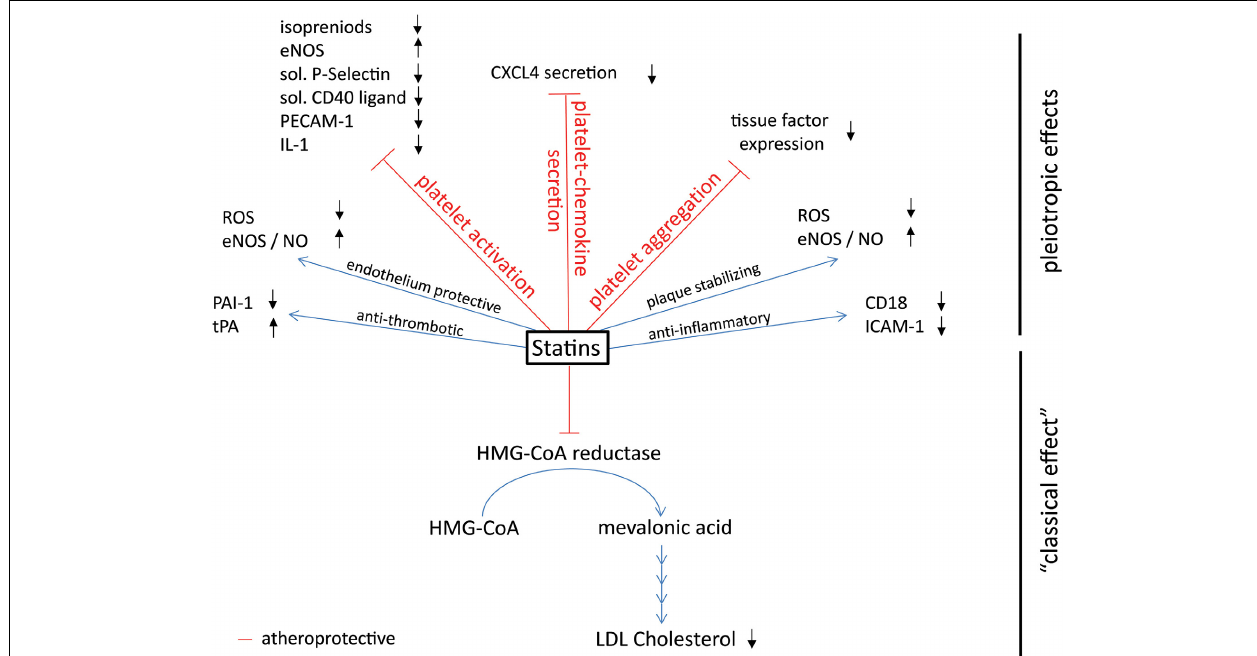
FIGURE 2 | Effects of platelet-derived chemokines on inflammatory cells and atherogenesis. Chemokines are stored in α -granules and secreted upon activation. Most platelet-derived chemokines act on the one hand on inflammatory cell differentiation and apoptosis. On the other hand, they act on